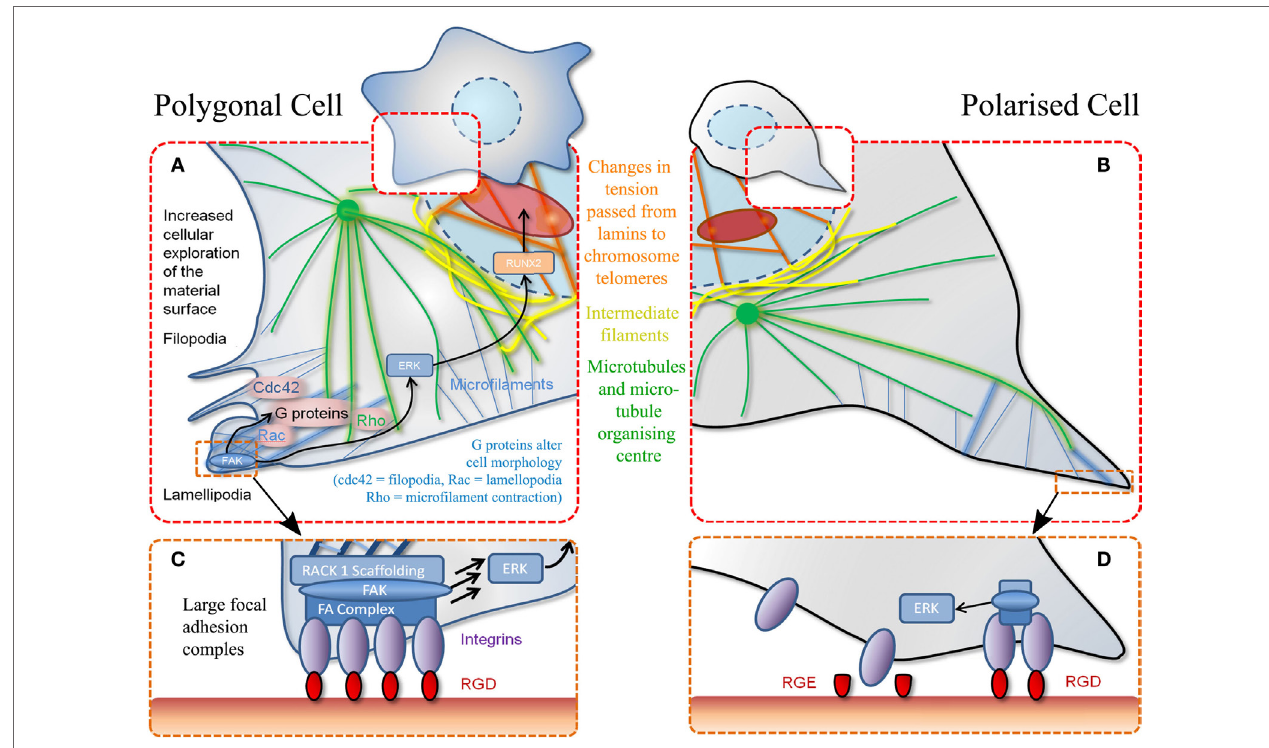
FiGURe 2 | Schematic of MSC adhesion . (A) Binding to material surface by lamellipodia stimulates a signaling cascade. This results in transcription factor expression (RUNX2) that stimulates differentiation via other G-proteins and effectors. Polygonal cells adhere to a material at various positions encouraging cell spreading and decreasing motility. (B) Polarized cells refer to adhesion at a single point through the same mechanisms described in (A) . (C) Increased magnification of adhesion event described in (A) whereby a favorable adhesion motif (RGD) is found in high density. (D) Magnification of adhesion event described in (B) whereby adhesion motif (RGD) is found in isolation. Also demonstrates non-adhesiveness of a closely related RGE (aspartic acid replaced with glutamic acid)